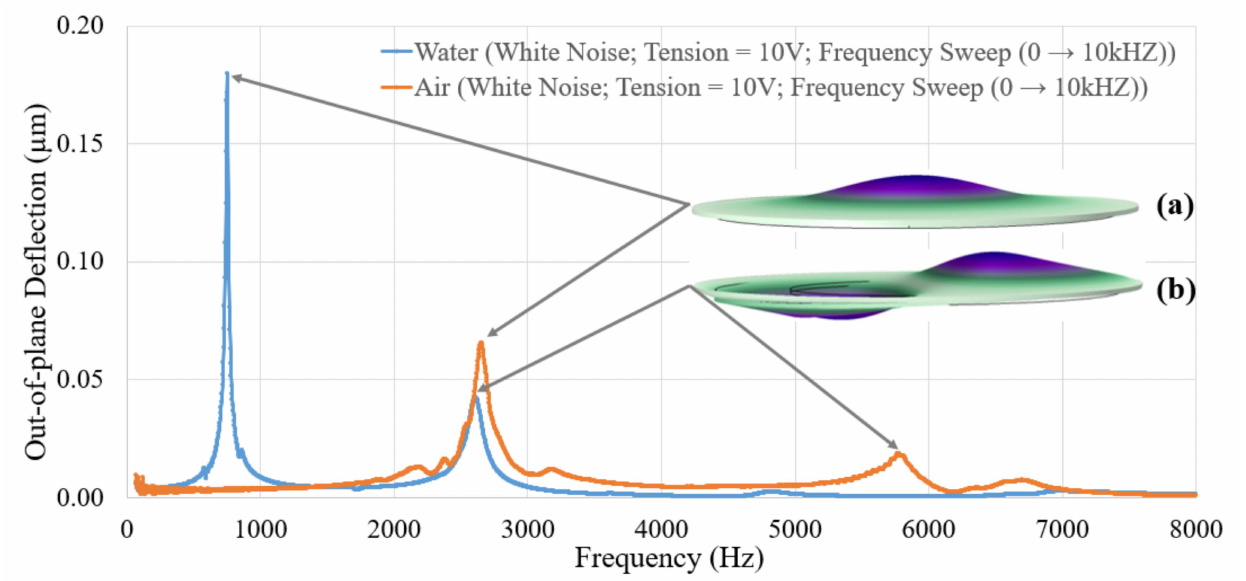
Figure 4. Resonance spectra of a vibrating membrane in air media, then in water media, and visualization of the ( a ) 1st mode shape and ( b ) 2nd mode